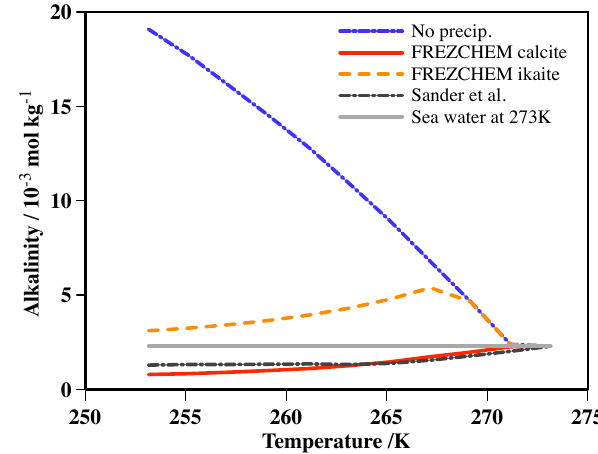
Fig. 1. Precipitation of calcium carbonate during the freezing of sea water.